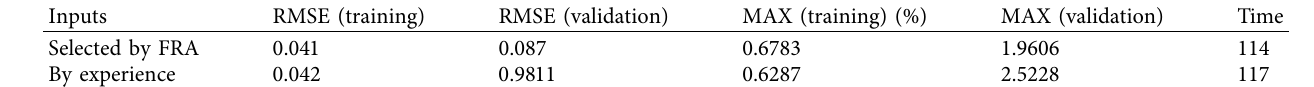
Table 1: Performance for different input variables using proposed RBF.